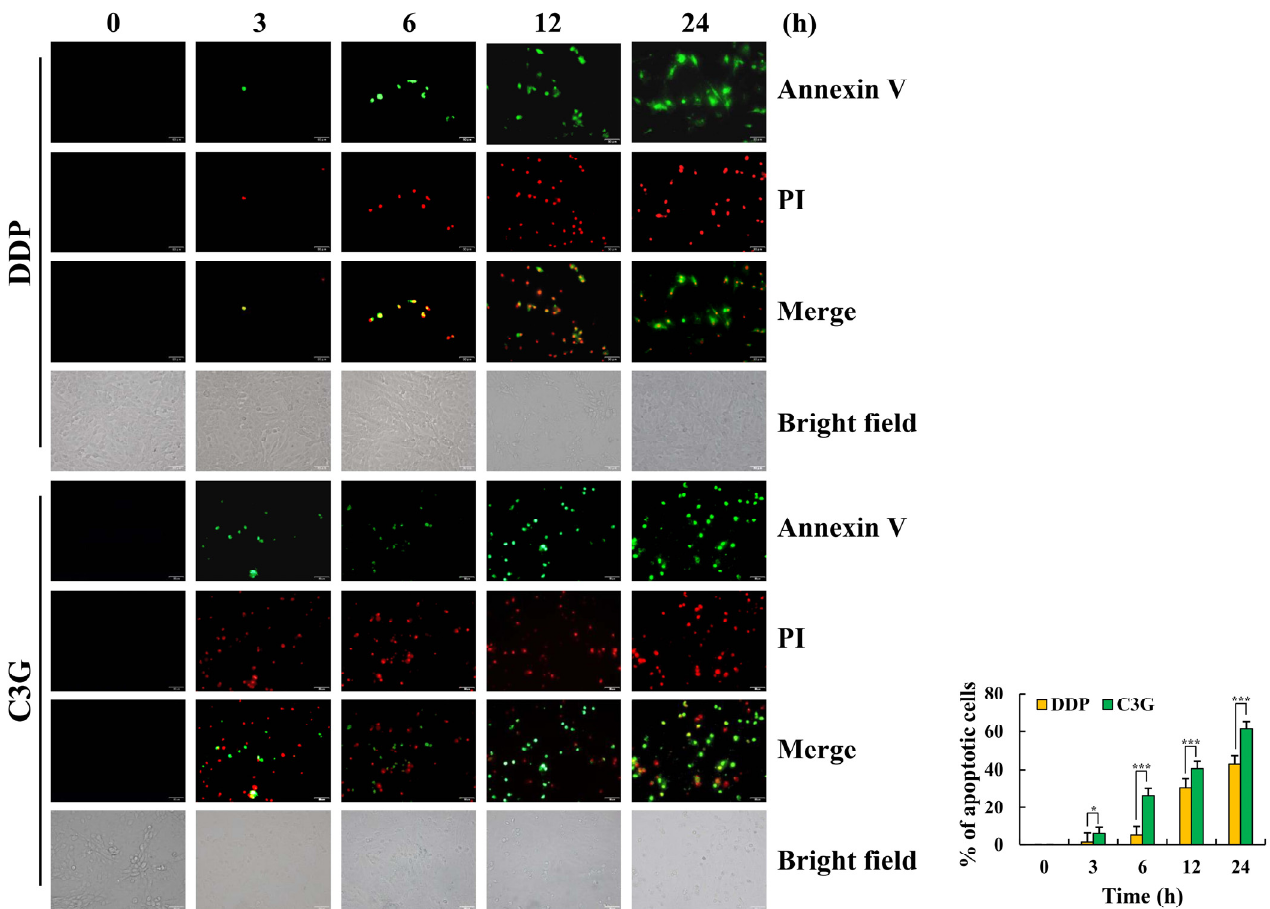
Figure 2. Apoptotic effects of C3G on MKN-45 cells. The fluorescence intensity and morphology of MKN-45 cells after Annexin V and PI painting were observed (original magnification 200×) (* p ≤ 0.05, *** p ≤ 0.001 vs. 0 h).